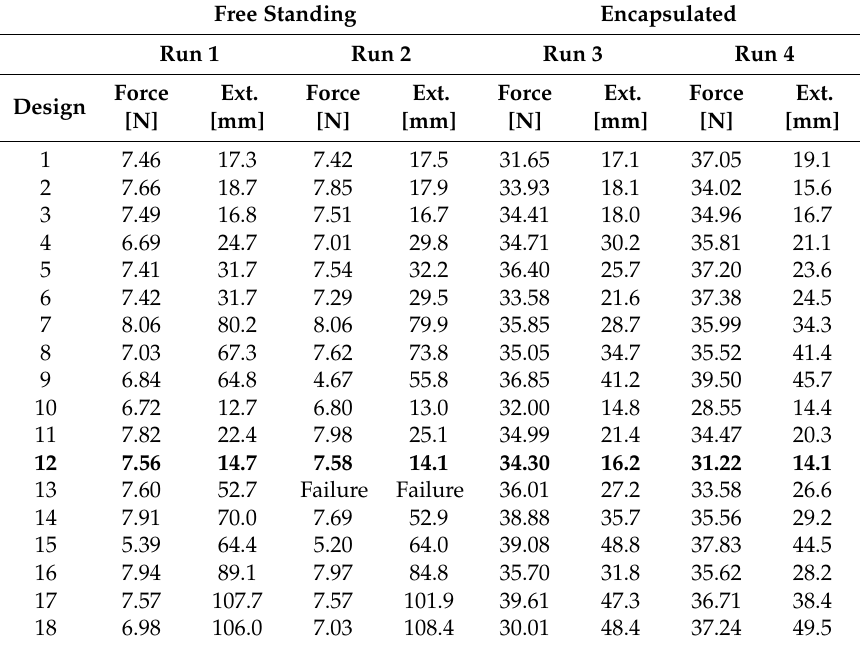
Table 3. Electrical measurements performed on the meanders during the tensile test. Free Standing Encapsulated Run 1 Run 2 Run 4